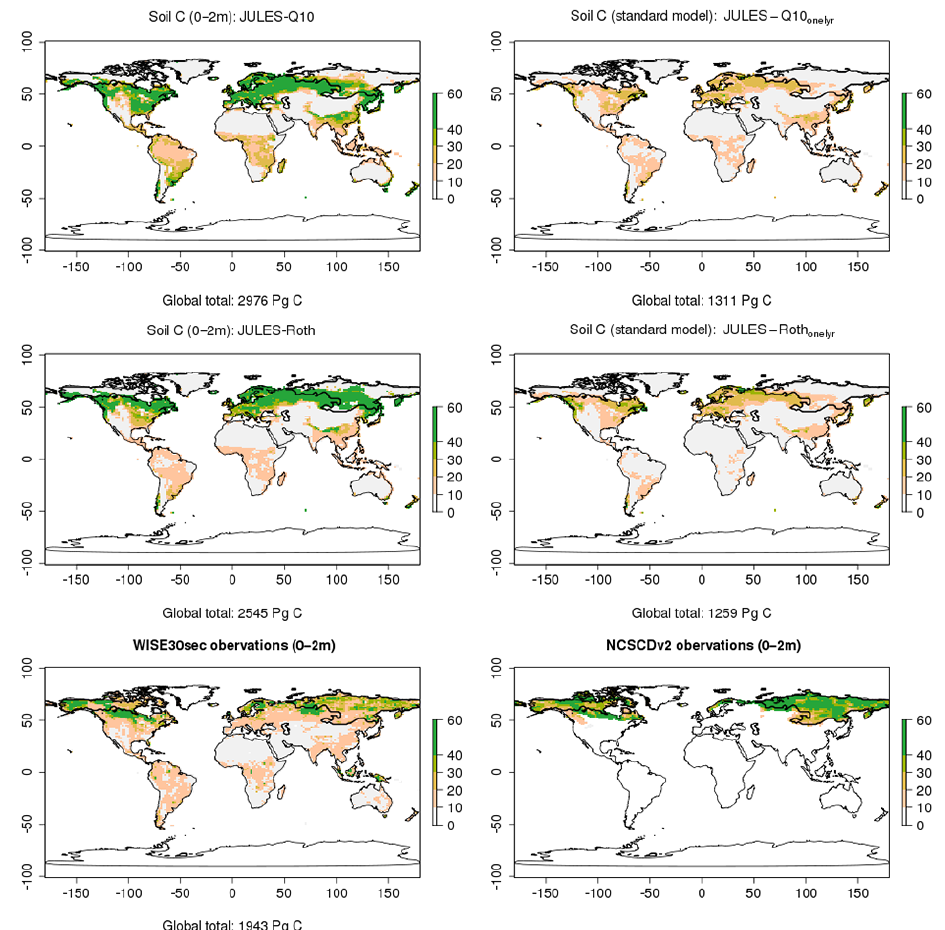
Figure 5. Soil carbon in the top 2m in kgm − 2 for the four different model simulations. The new vertically discretized model versions are on the left and the standard model versions are on the right. The WISE30sec observed data set is shown at the bottom left and the NCSCDv2 at the bottom right. Table 1. Total soil carbon in top 2m (PgC) for the regions assessed in this paper (top three lines) and for the following biomes defined by Olson (2001): tropical forest; boreal and coniferous forest; and tundra (bottom three lines). Bold font indicates the vertically discretized soil carbon models. Region WISE30sec NCSCDv2 JULES-Roth JULES-Roth onelyr JULES-Q10 JULES-Q10 onelyr Global 1943 2545 1259